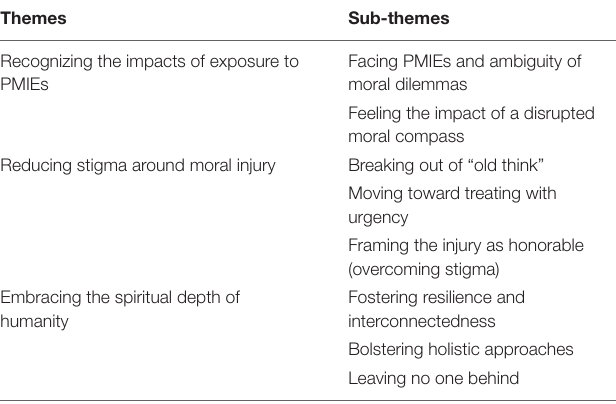
TABLE 2 | Themes and subthemes of the thematic analysis. Themes